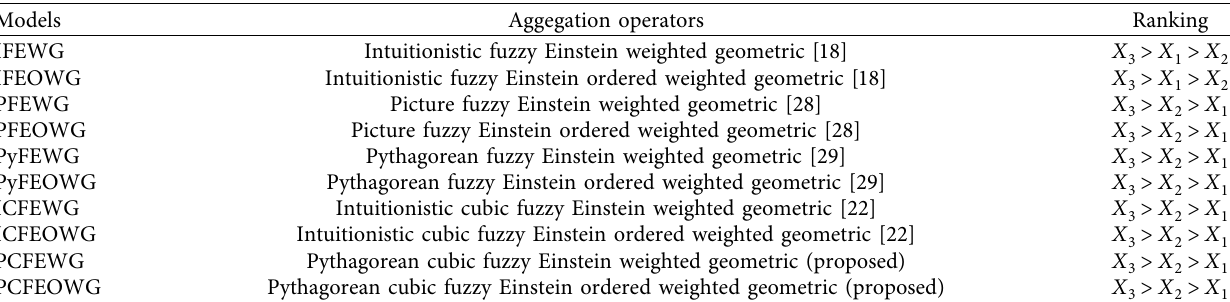
Table 4: Final ranking comparative study with existing aggregation